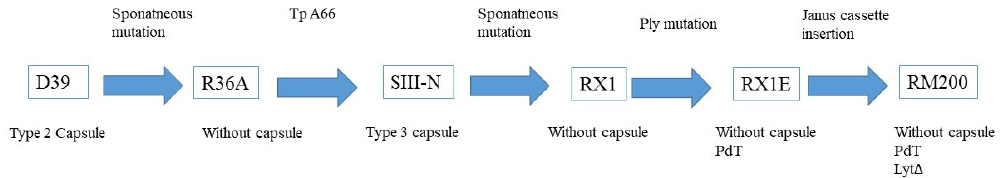
Figure 1. Development/genealogy of the RM200 serotype [46–48,50,54].